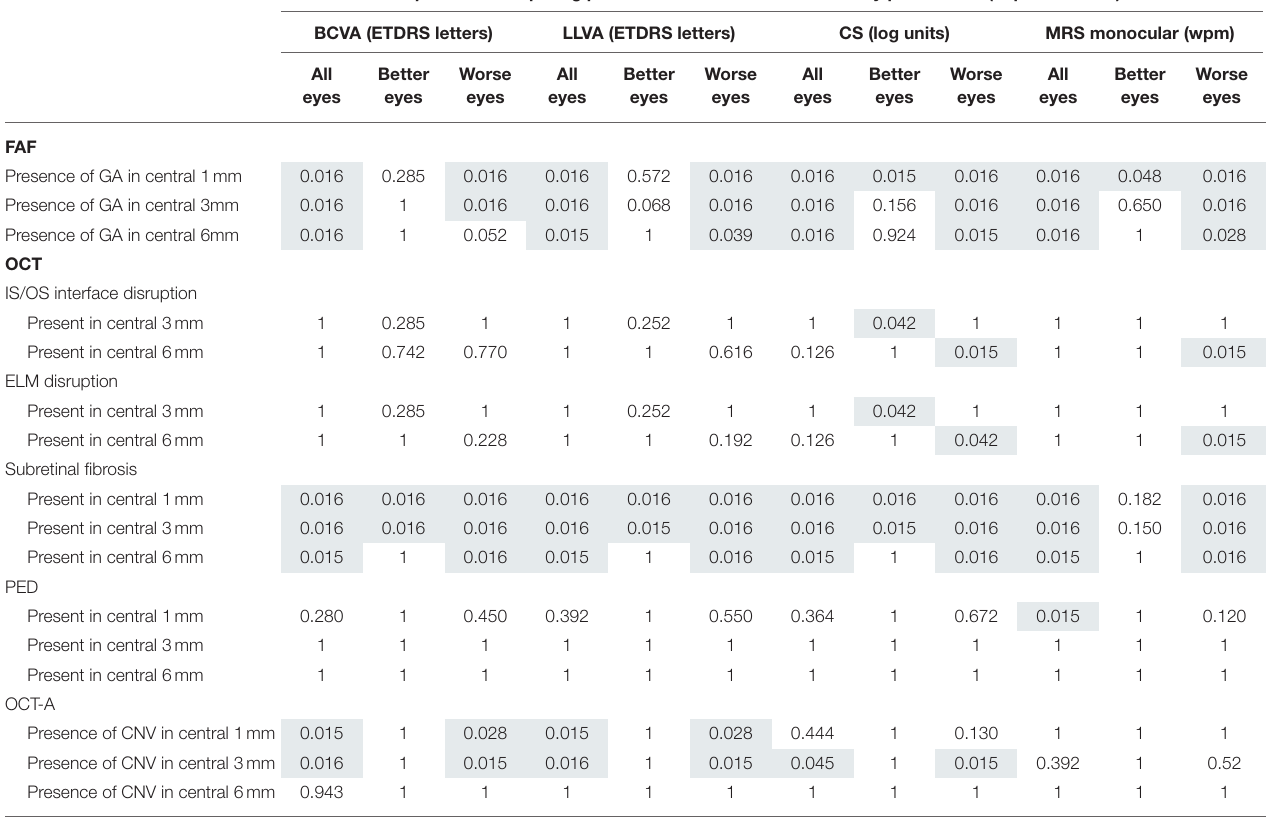
TABLE 4 | Relations between location of lesions and visual function. p -values comparing presence of lesion and visual acuity parameters (unpaired t